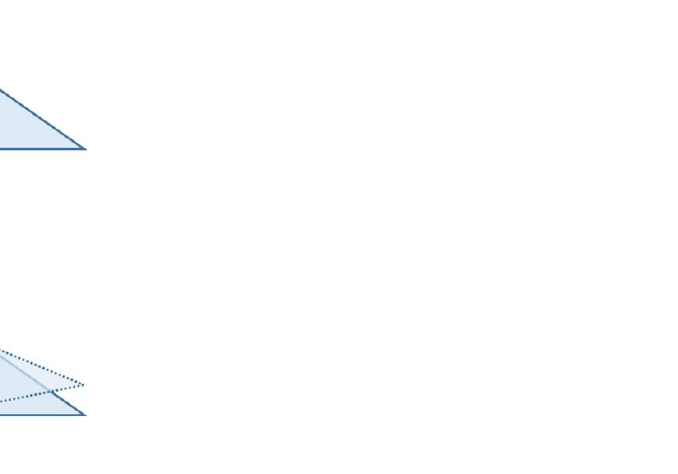
Figure 5. Displacement of the rotation body with labeled angles and lengths.